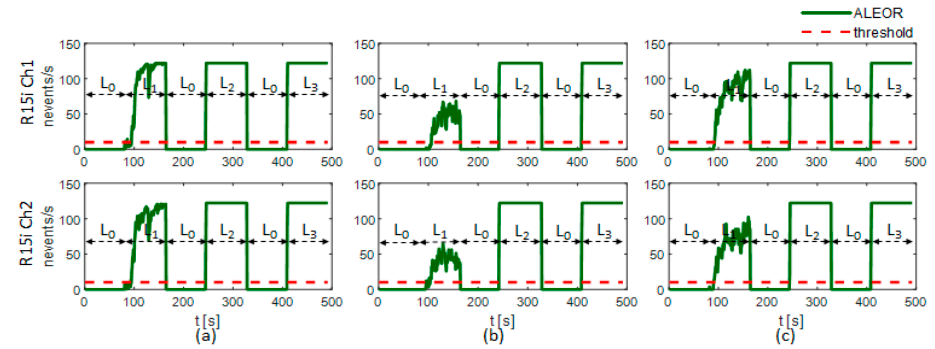
Figure 13. ALEOR under different pressure conditions: ( a ) P 0 , ( b ) P 1 , ( c ) P 2 (After adding a white noise with ρ = 10).